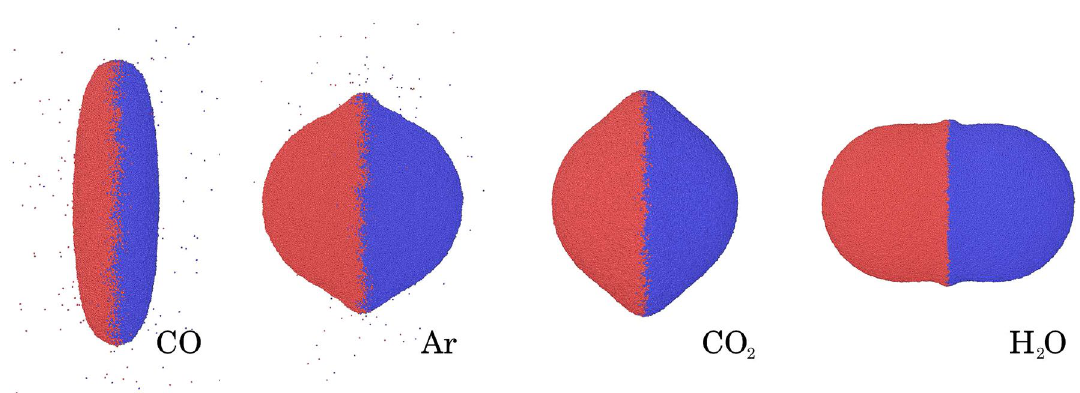
Figure 3. Configuration of the merged cluster at the end of the simulation for the species indicated. Color denotes initial NP affiliation. The snapshots are at the same